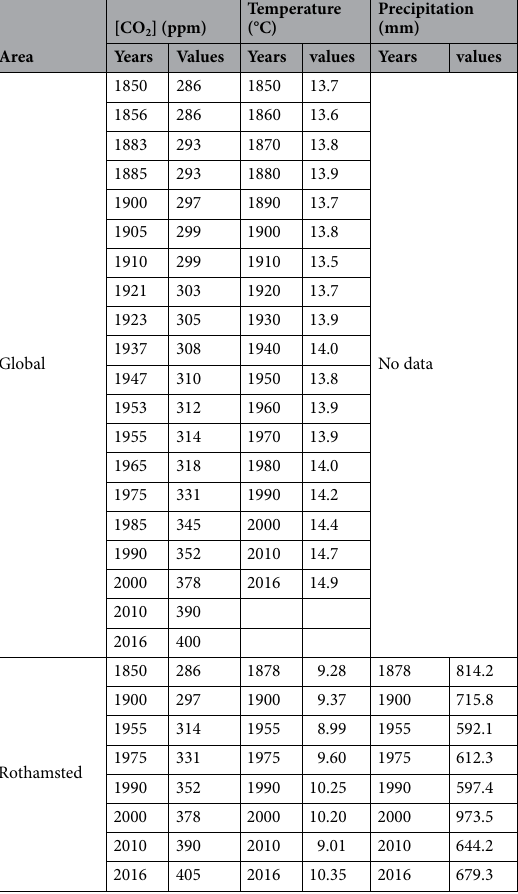
Protein content. Grain protein content (%) was determined according to Suchy et al. 22 . Mineral composition. In each case, 100 mg of pulverized dry grain samples were analysed 23 . C and N concen- trations (%) were determined using an elemental analyzer (EA1108; Carlo Erba Strumentazione, Milan, Italia). In addition, micro- and macro-nutrients (Cu, Zn, Fe, Mn, K, P, Mg, Ca and Na) were quantified using ICP/ OES (inductively coupled plasma/optical emission spectrometry, iCAP 6500 Duo, Thermo Fisher Scientific, Waltham, USA). Data analyses. Given the long time-series considered, wheat samples received from herbaria were har- vested from different locations and periods. Distinct genotypes were represented within each sampling year, with different number of repetitions. In view of the available data, the statistical analyses aimed to evaluate the trend of grain quality parameters over 166 years by calculating the average per year, without considering the genotype effect. To study the ‘year’ effect on the different parameters measured for global and Rothamsted grain samples, a simple analysis of variance (ANOVA) was performed by using STAT GRA PHICS Centurion version 17.1.02 program (Bitstream, Cambridge, MN). For analytical variables, a multiple-range test (Fisher’s least significant differences, LSD) was applied to test for statistical differences between years. Multifactor analyses of variance and Pearson correlation analyses were performed between the different parameters and the environmental fac- tors ([CO 2 ], temperature and precipitation) with the R software (RStudio v.3.4.2, 2017; Boston-Seattle, USA). The correlations between variables were considered significant when p < 0.05.